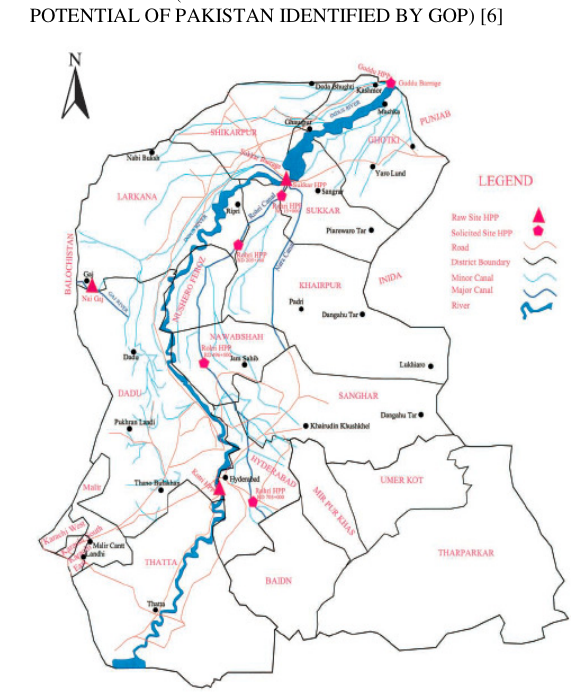
FIG. 3. IDENTIFIED HYDROPOWER POTENTIAL (RAW & SOLICITED) SITES